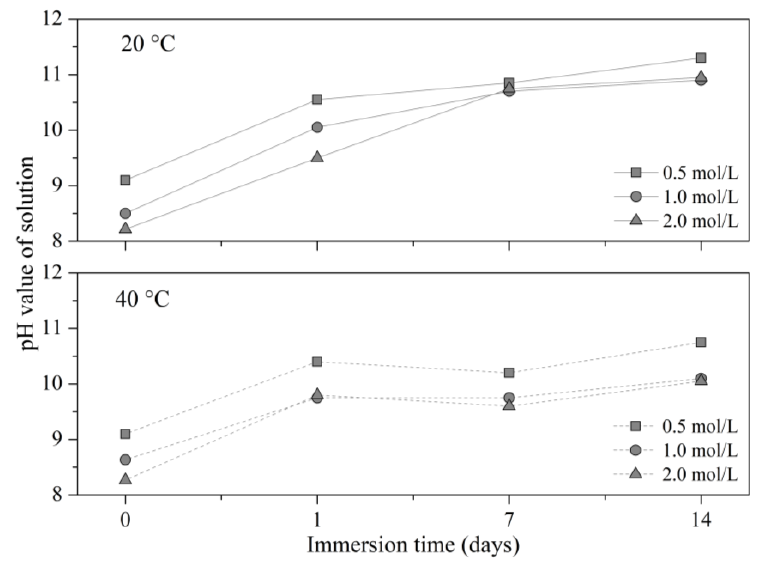
Figure 7. pH values of the DAP solutions varying with the immersion time and temperature. On the other hand, the XRD patterns of the untreated RFA and RFA treated with 0.5 mol/L, 1.0 mol/L and 2 mol/L at 7 days and 20 °C are shown in Figure 8. For 0.5 mol/L – 7d – 20 °C, a decrease in the main peaks associated with Ca(OH) 2 was identified at 18° and 34° of the 2 θ axis, suggesting that it was consumed by the reaction with DAP, producing new minerals identified as calcium phosphates. In addition, a slight shift towards lower values was identified in the halo between 31° and 33° of the 2 θ axis, which is decisive, considering that within this range, especially at 33°, the main peak associated with HAP was expected. The reaction between Ca(OH) 2 and DAP produced new mineral precipitates identi- fied in the treated RFA as calcium phosphates (Ca 3 (PO 4 ) 2 ): dicalcium phosphate Ca(HPO 4 )2H 2 O, octacalcium phosphate CaH 2 (PO 4 )OH and Ca 3 (PO 4 ) 2 , which can further react with OH - and Ca 2+ in the solution to produce HAP, (Ca 10 (PO 4 ) 6 (OH) 2 ) [47]. However, for concentrations of 1 mol/L and 2 mol/L, no HAP formation was identified, which could be explained by the low amount of Ca(OH) 2 to react with HAP at high concentrations. Additionally, unlike HAP, the formation of dicalcium phosphate Ca(HPO 4 )2H 2 O and oc- tacalcium phosphate Ca 8 H 2 (PO 4 )OH occurred in environments with low pH values and was therefore less stable [54]. These results explain the fact that the lower the DAP con- centration, the greater the decrease in the adsorption value of the RFA, because the for- mation of a stable phosphate such as HAP allows for the surface strengthening and pore filling of the RFA, as is evidenced in Figure 8 for 0.5 mol/L.